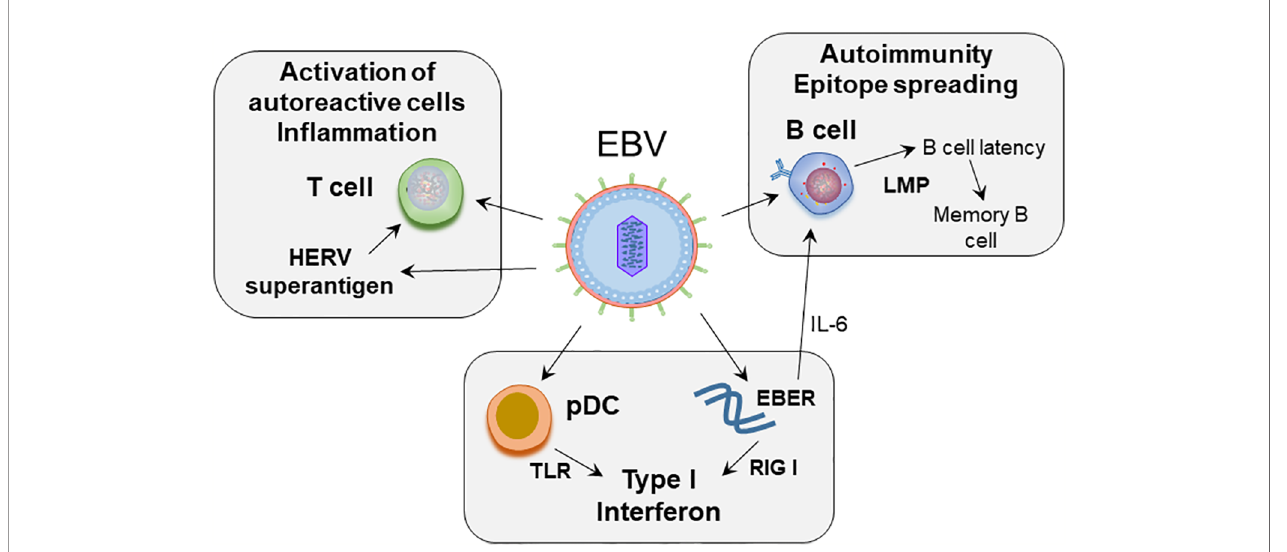
FIGURE 1 | Proposed role of EBV in SLE pathogenesis. EBV infects naïve B cells. The infected B cells enter the memory B cell compartment through germinal center like reaction, mediated by the expression of latent membrane proteins. EBV maintains latency in the resting memory B cells. EBERs, non-coding RNA expressed by EBV, can mimic dsRNA, and activate RIG-I leading to production of type I interferons. EBERs also induce growth factor IL-6 and regulate B cell survival. EBV can act on plasmacytoid dendritic cells (pDC). Initial binding of virus is mediated by class II MHC on pDCs, following which through engagement of TLR7 and 9, EBV RNA and DNA can induce type interferon secretion by pDCs. EBV induces superantigen on HERV-K18, which can induce unregulated T cell activation.